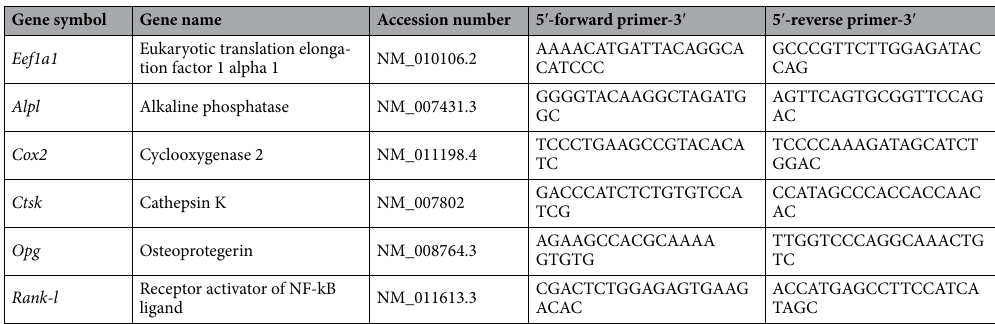
Table 2. Primer sequences of target genes and reference gene Eef1a1 used in this